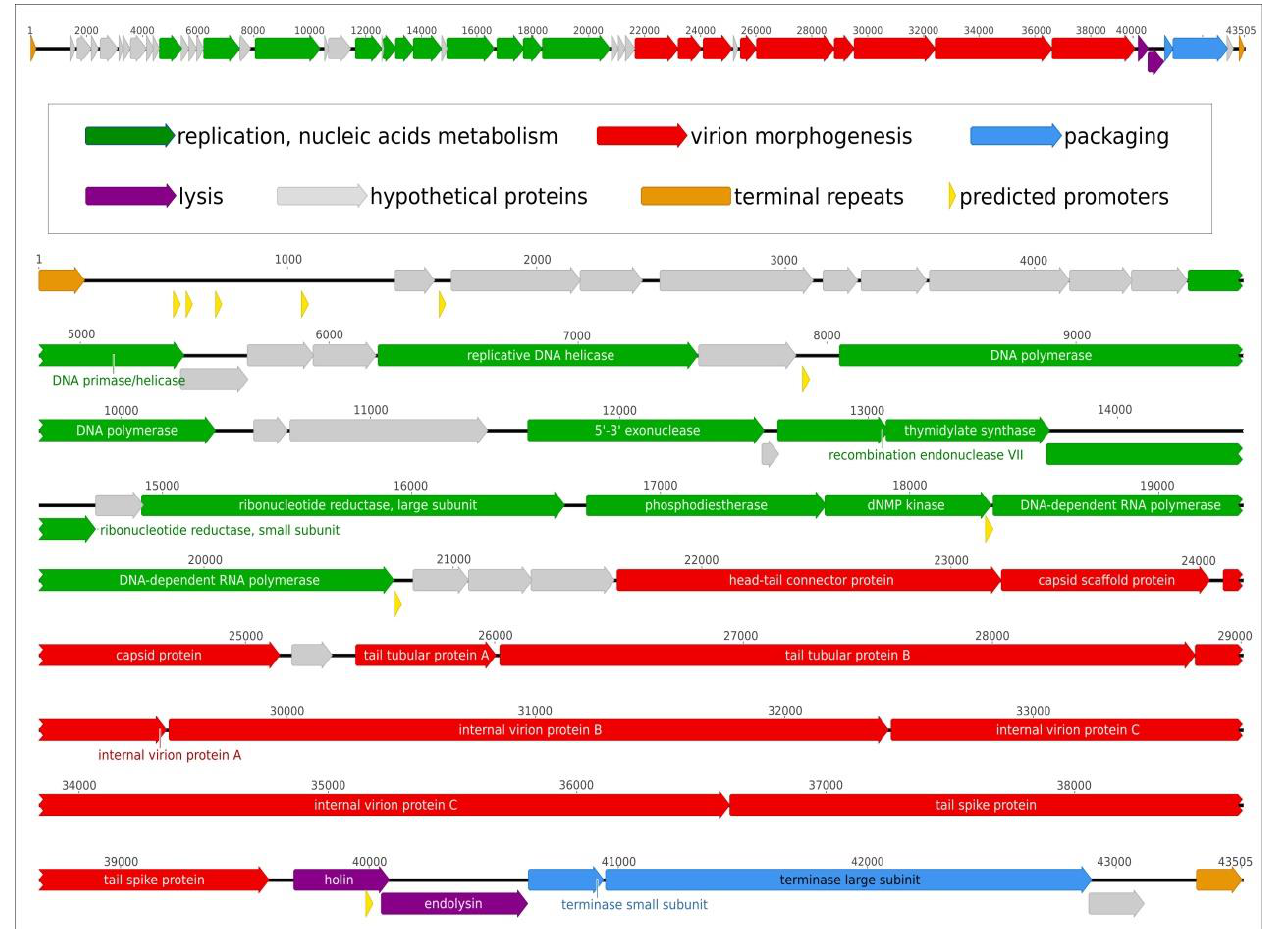
Figure 3. Genetic map of Acinetobacter phage Aristophanes. Upper picture: the basic scheme of the genome. Lower picture: the genetic map and putative functions of genes (Table S1).